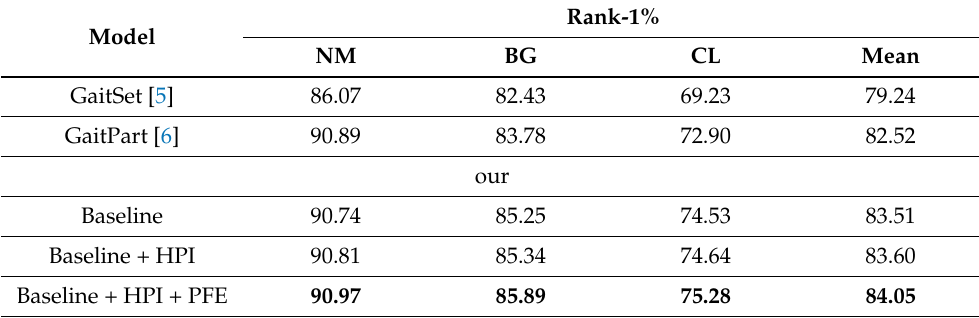
Table 6. For real personal physiological features, we conducted ablation experiments in the Multi- state Gait dataset, excluding identical-view cases. The bolds indicate the best accuracy in this